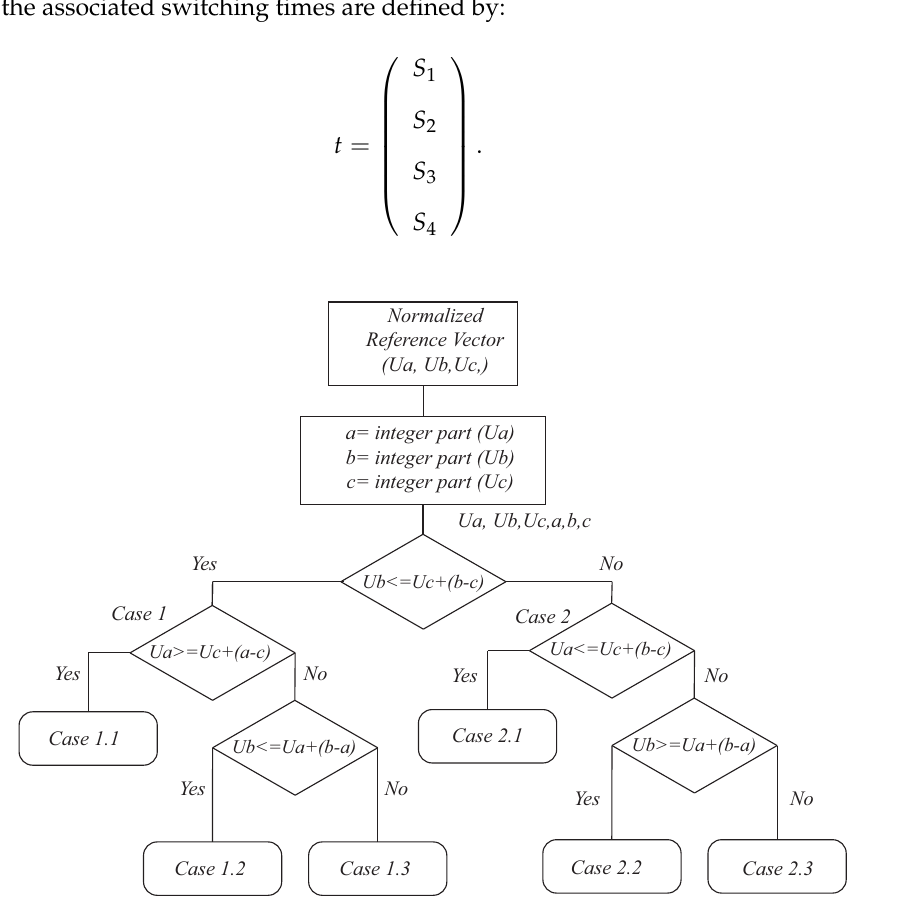
Figure 14. Flowchart for the Three-Dimensional Space Vector Modulator (3D-SVPWM) algorithm.